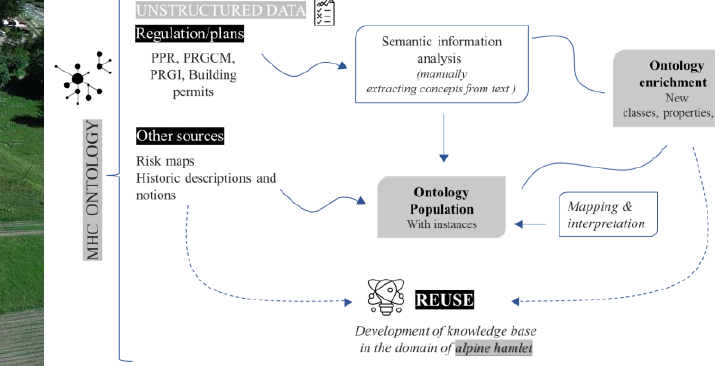
Figure 3. Ontology enrichment and population workflow with data from